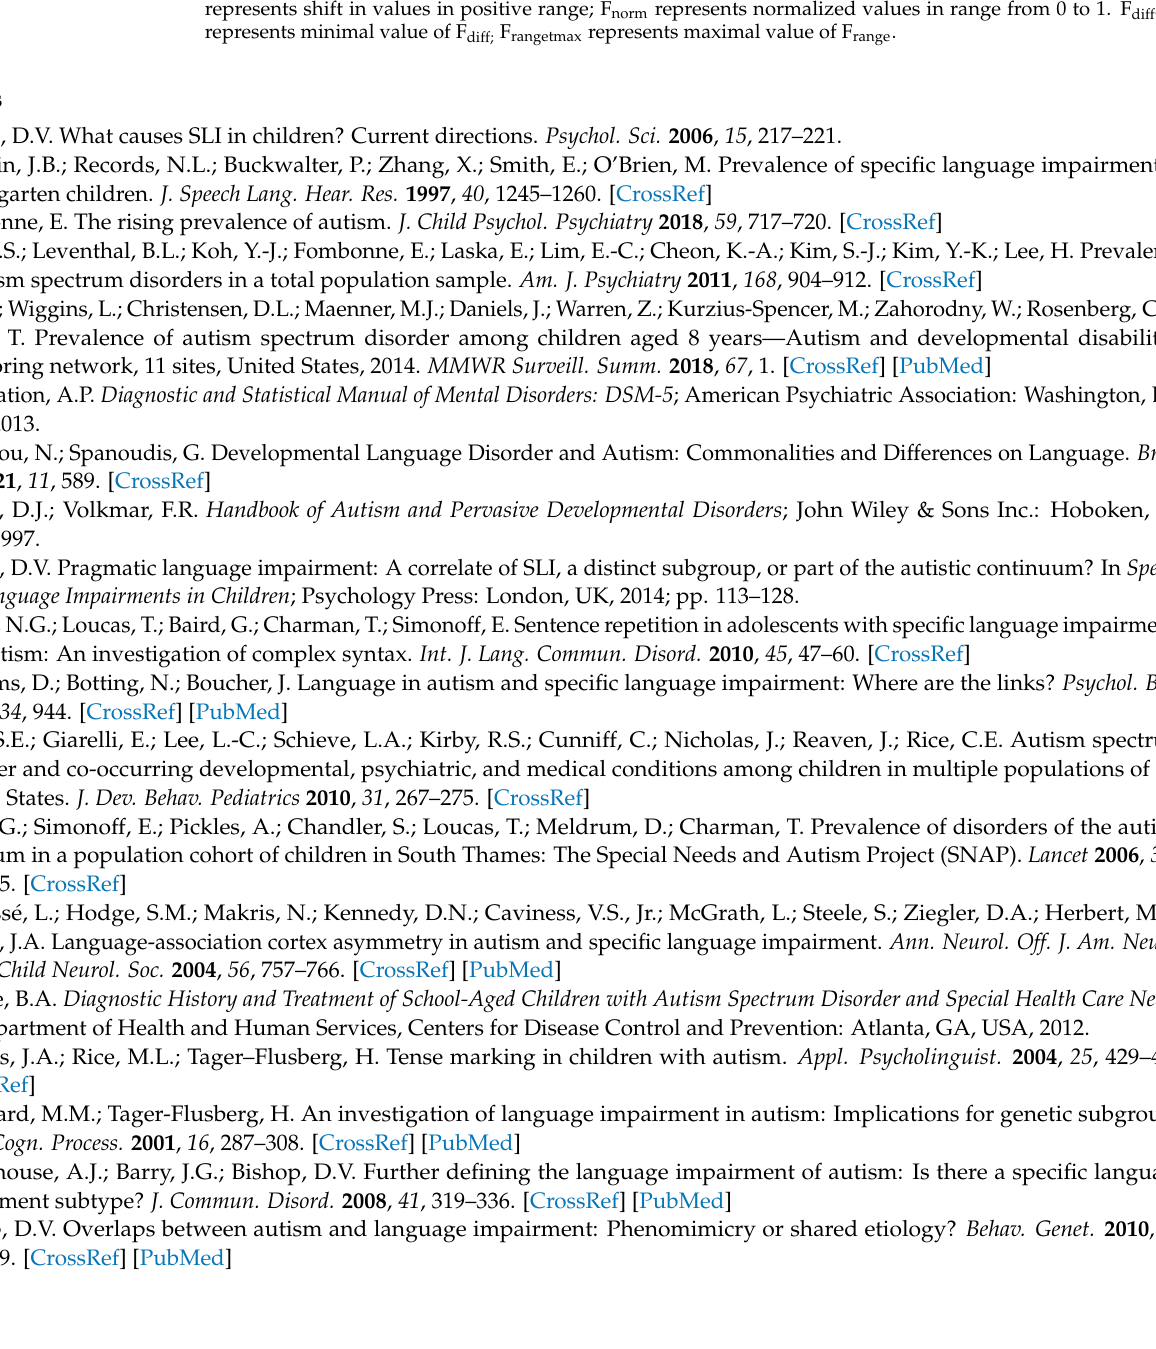
Note: F diff represents difference between mean values of spectral power between left and right regions; F range represents shift in values in positive range; F norm represents normalized values in range from 0 to 1. F difftmin represents minimal value of F diff; F rangetmax represents maximal value of F range